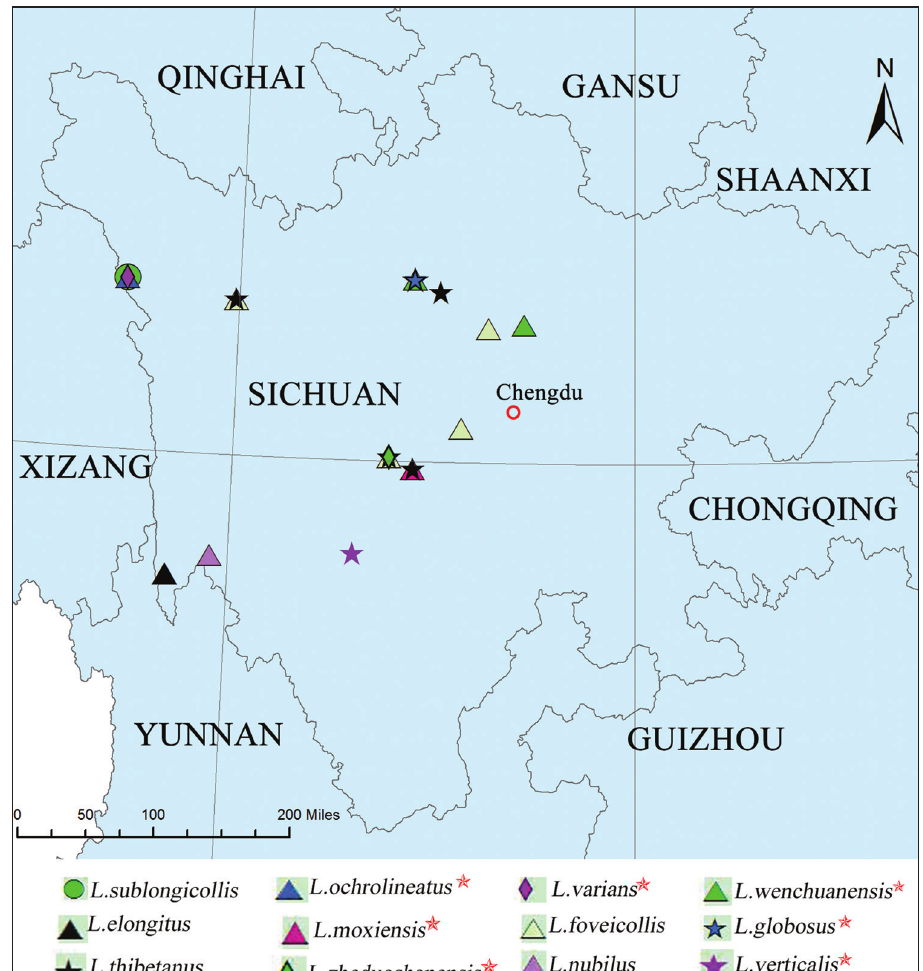
Figure 24. Distribution map of Leptomias species from Sichuan (all endemic species are marked by five- pointed stars).